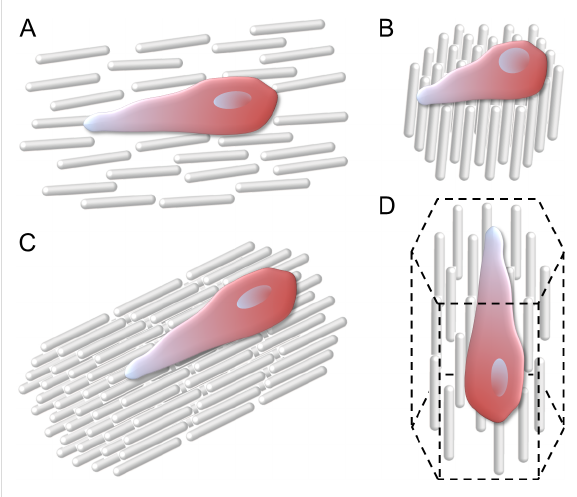
Figure 2: Architectures of liquid crystalline scaffolds and their interac- tions with adherent cells. Each rod represents a constituent polymer, colloid or molecule. (A) A cell attached on a substrate in nematic order; (B) a cell attached on a smectic substrate (perpendicular or oblique to the rod alignment); (C) a cell attached on a surface of smectic scaffold (parallel to the rod alignment); (D) a cell entrapped in a columnar scaf- fold. Note that the cells are elongated along the direction of rod align- ment in panels A, C, and